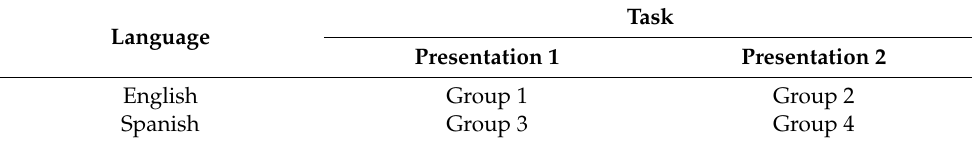
Table 4. Study design.